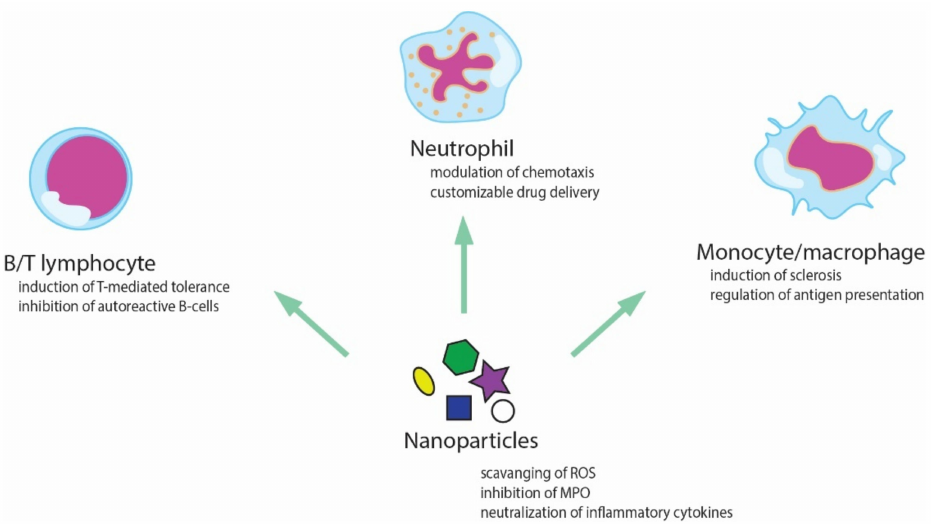
Figure 7. Possible interactions between nanoparticles and different components of the immune